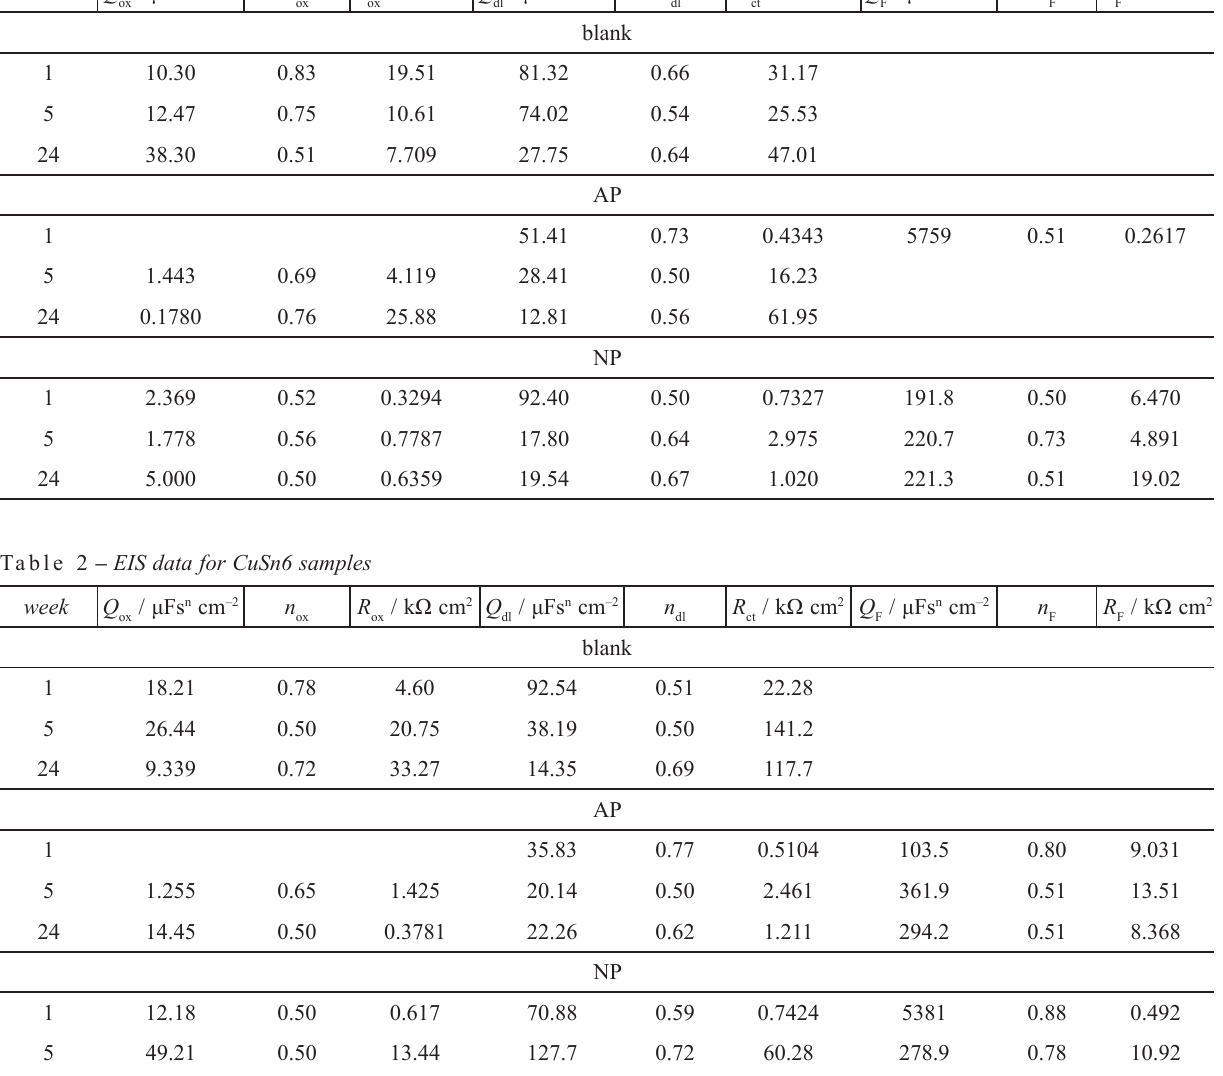
Table 1 – EIS data for Cu samples week